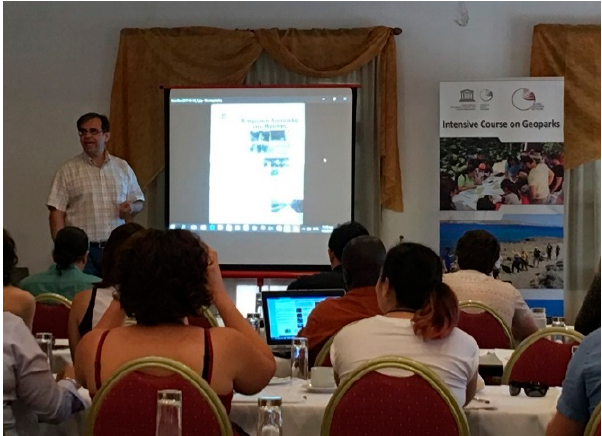
Figure 8. Lesvos International Intensive Course on Global Geoparks with participants from all over the world.